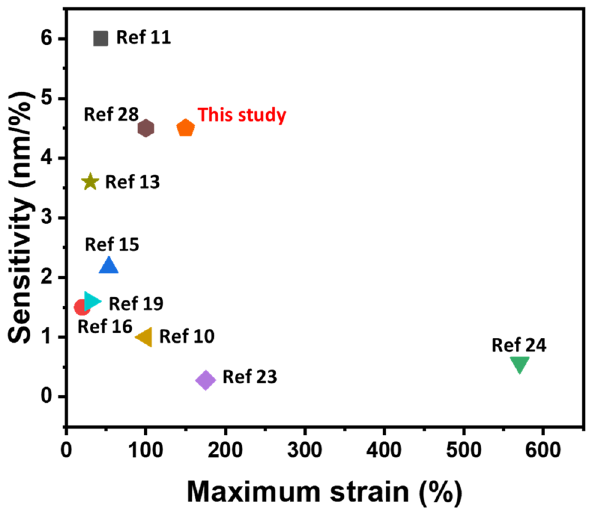
Figure 10. Comparison of working range and sensitivity of the stretchable colorimetric strain